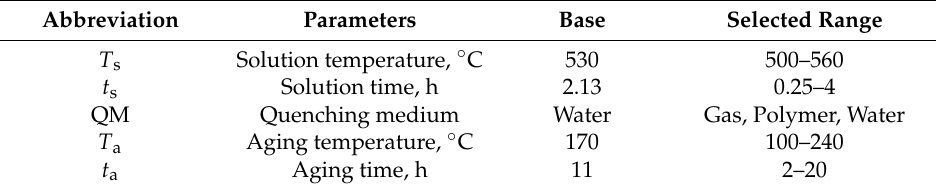
Table 2. Selected range of the heat treatment parameters and their abbreviations in the following text.